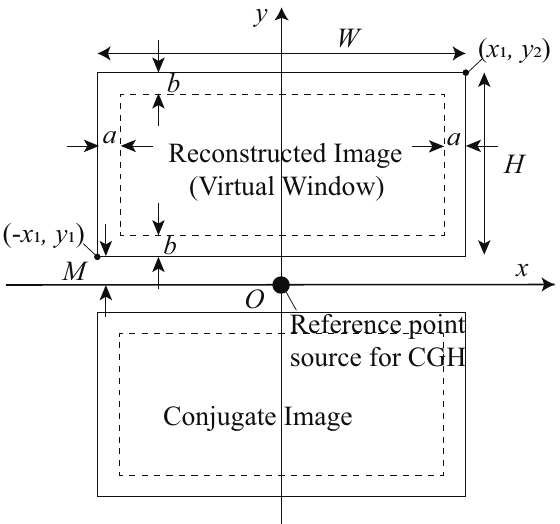
Figure 3. Coordinates for virtual window in the final hologram plane. The reference point source for CGH is placed at the